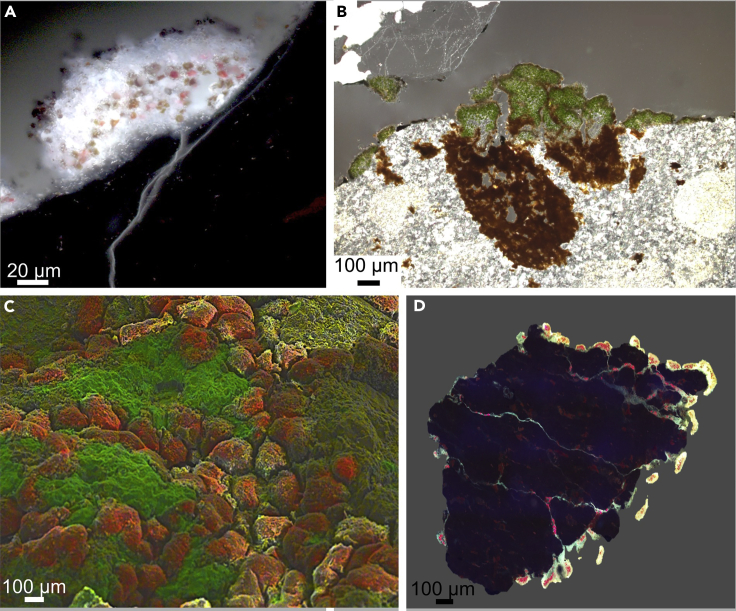
Evidence for Penetration of the Lithomatrix by Lichens(A) Fluorescence microscopy of grit stone showing fungal hyphae (white; chitin autofluorescence) penetrating the grit surface and green algal photobionts (red; chlorophyll autofluorescence) indicating the microstructures that potentially lead to a deterioration of the grit stones; (B) Light microscopy of grit cross section with lichen thalli (green) and cavities filled with brown particles underneath that demonstrate that lichens accumulate fine material; (C) Artificially colored SEM image with lichen thalli (red) embedded into the grit (green) showing that the lichen thalli are embedded into the surface of the grits; (D) Fluorescence microscopy of whole grit stone showing fungal hyphae (white; chitin autofluorescence) and green algal photobionts (red; chlorophyll fluorescence) inside of a grit stone. SEM, scanning electron microscopy.